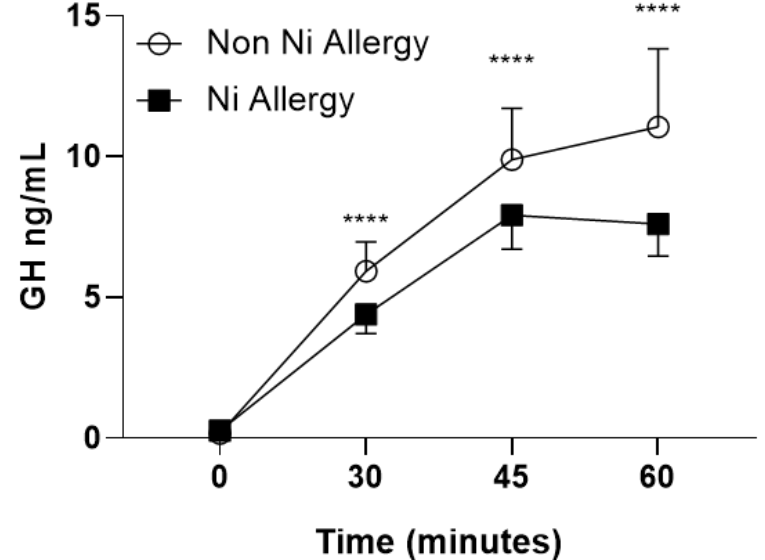
compared to nonallergic ones (Figure 1).